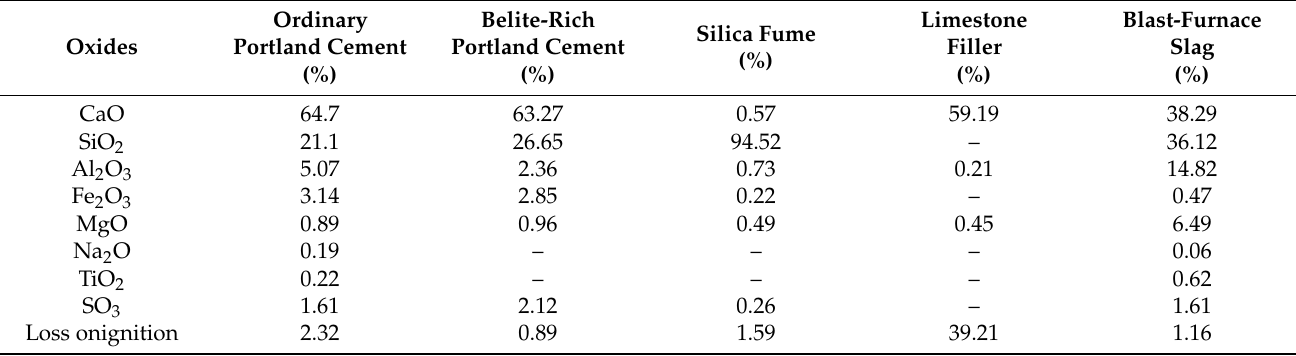
Table 1. The chemical composition of the materials.